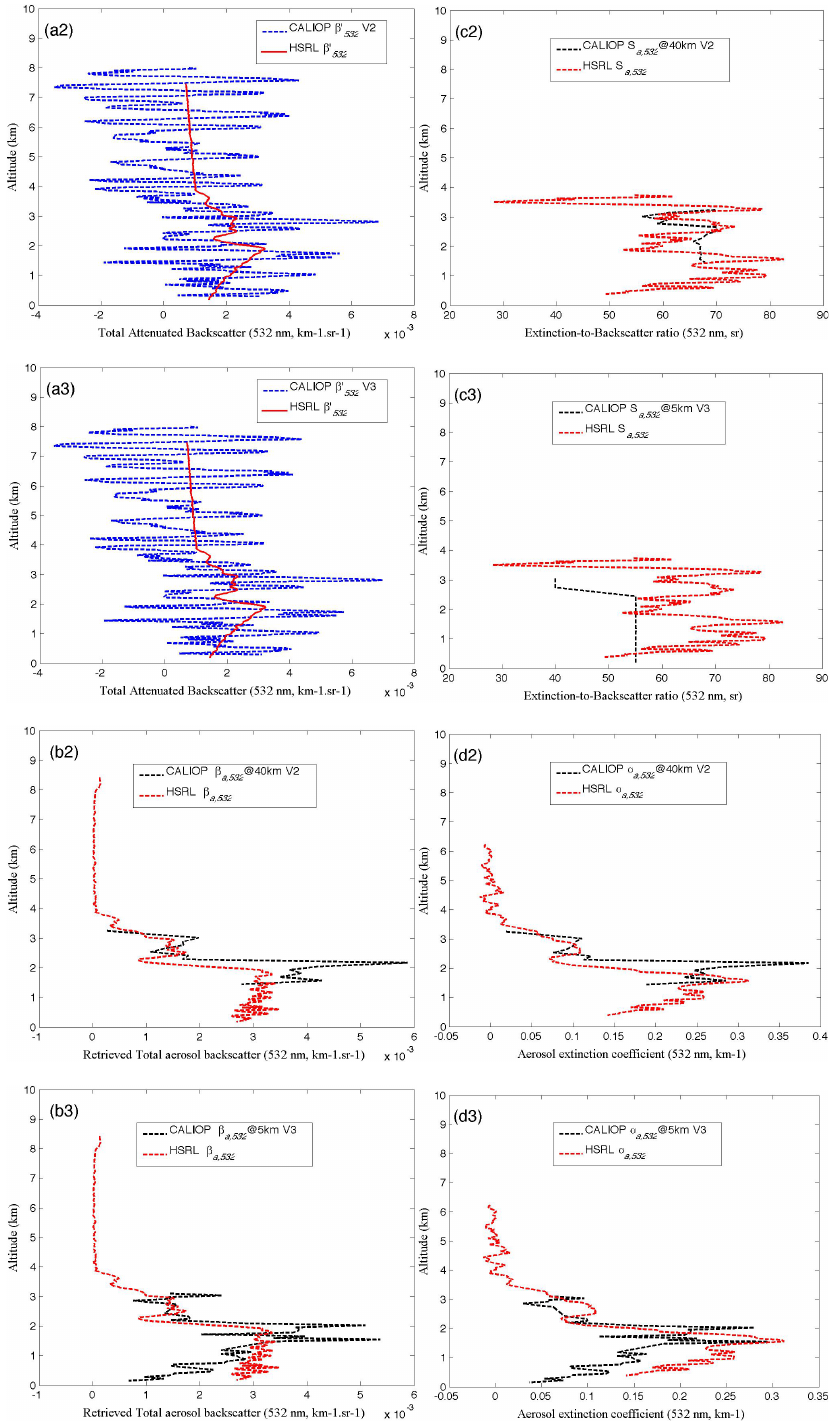
0 Fig. 4. 4 August 2007 – (a2) HSRL (red) and CALIOP version 2 (blue) β profile, both at ∼ 4/3km resolution, (b2) HSRL β a , 532 (red) and 532 CALIOP version 2 β a , 532 @40km profile (black), c2) HSRL S a , 532 (red) and CALIOP version 2 S a , 532 @40km profile (black) and (d2) HSRL α a , 532 (red) and CALIOP version 2 α a , 532 @40km profile (black). All profiles are the closest to CATZ-Sanders. The CALIOP and the HSRL track are ∼ 900m away from each other and the HSRL overpass is ∼ 30 min early (17:52UTC) compared to CALIOP (18:27UTC); (a3) through (d3) are the same as (a2) through (d2) but using version 3 for all CALIOP